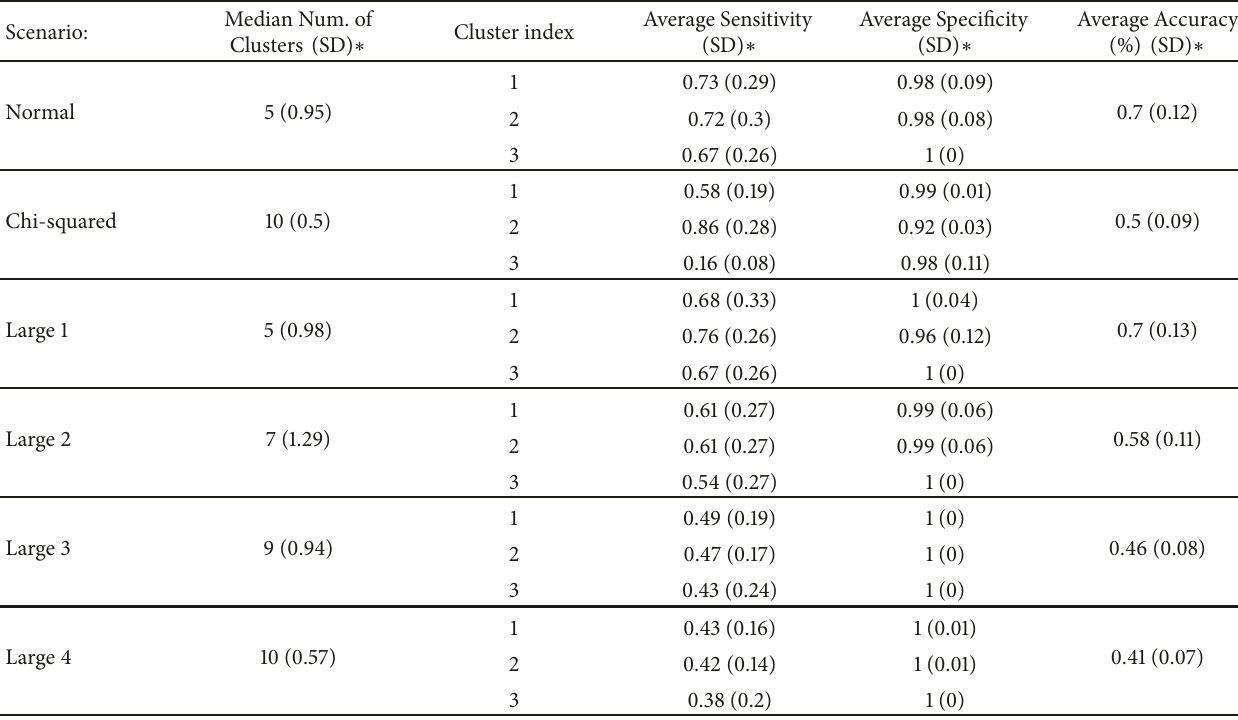
Table 2: Kmeans simulation assessments for three foci-level